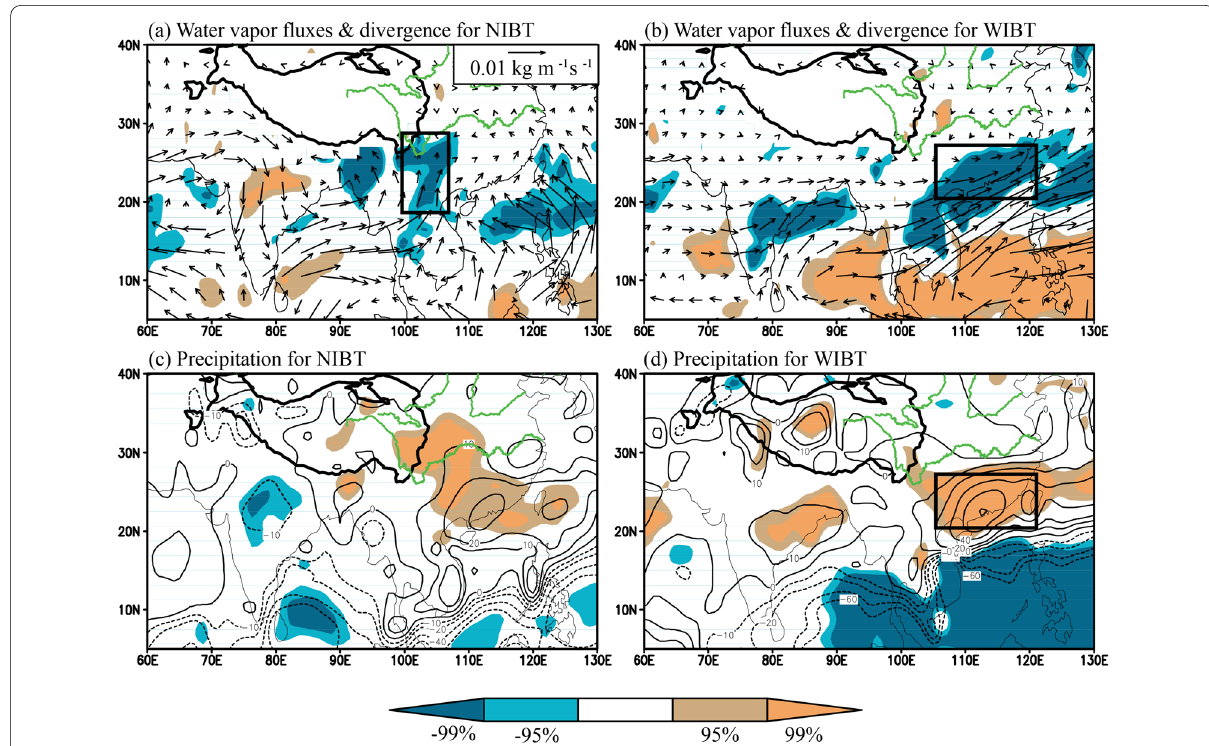
Fig. 5 Anomalous vertical (surface–600 hPa) integral water vapor fluxes (vector, kg m − 1 s − 1 ) and divergence (shading, 10 –5 kg m − 2 s − 1 ) regressed upon the ( a ) NIBT and ( b) WIBT indices in winter for the period 1979–2019. ( c) and ( d) as in (a) and (b), respectively, but for anomalous precipitation (units: mm). The black box in (a) denotes Southwest China (SC; 18–28 °N, 100–107 °E), and the black box in (b) and (d) denotes the SC‑SEC region (20–27 °N, 105–123 °E). The two regions are used to calculate the time series of area‑mean water vapor divergence in Fig. 6. Shadings denote positive/negative water vapor divergence and precipitation anomalies significant at the 95% and 99% confidence levels as shown by the color